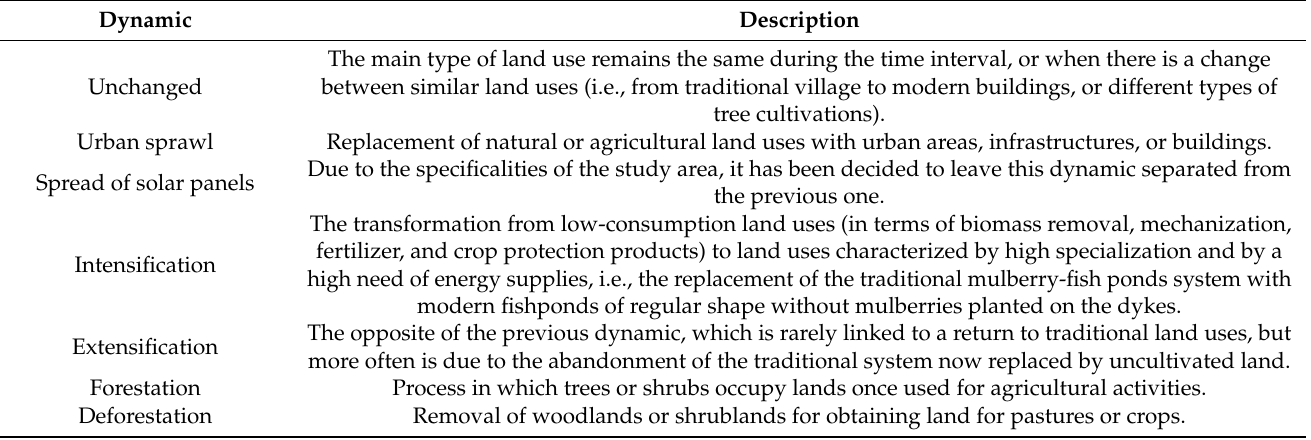
Table 2. The dynamics used for classifying the land use changes in the period